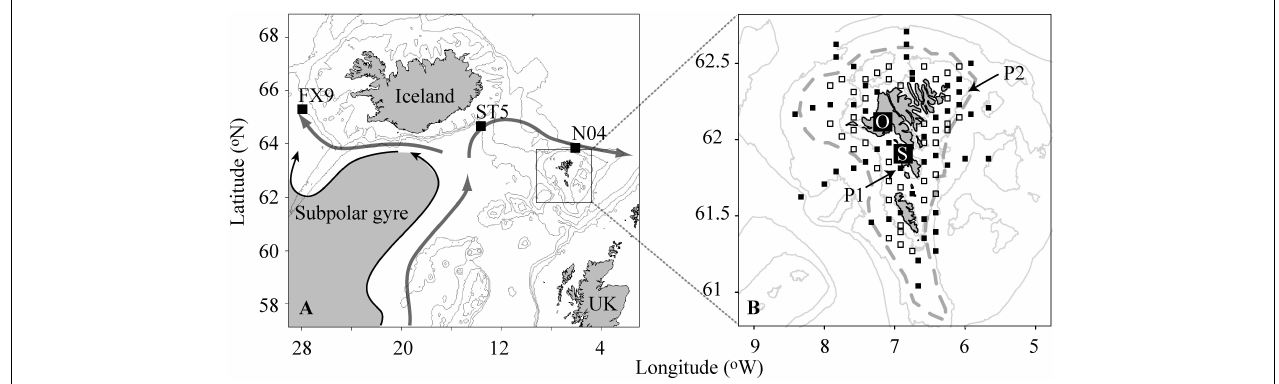
FIGURE 1 | (A) The North East Atlantic. The squares show the positions of the nutrients time series stations, while the gray lines represent the 200, 500, and 1000 m bottom depth contours, respectively. The subpolar gyre and the northward flow of North Atlantic waters carried by the gyre are illustrated by arrows. (B) The Faroe Shelf. The filled squares show survey haul positions and biological oceanography stations occupied during the 0-group survey in the second half of June, while the open squares show survey haul stations only. P1 and P2 are stations on which the PPI is based (refer to section “Phytoplankton”). O and S denote fixed coastal stations on the shelf. The gray lines represent 100, 200, and 500 m bottom depth contours, and the gray dashed line is the average position of the Faroe shelf front (Larsen et al.,